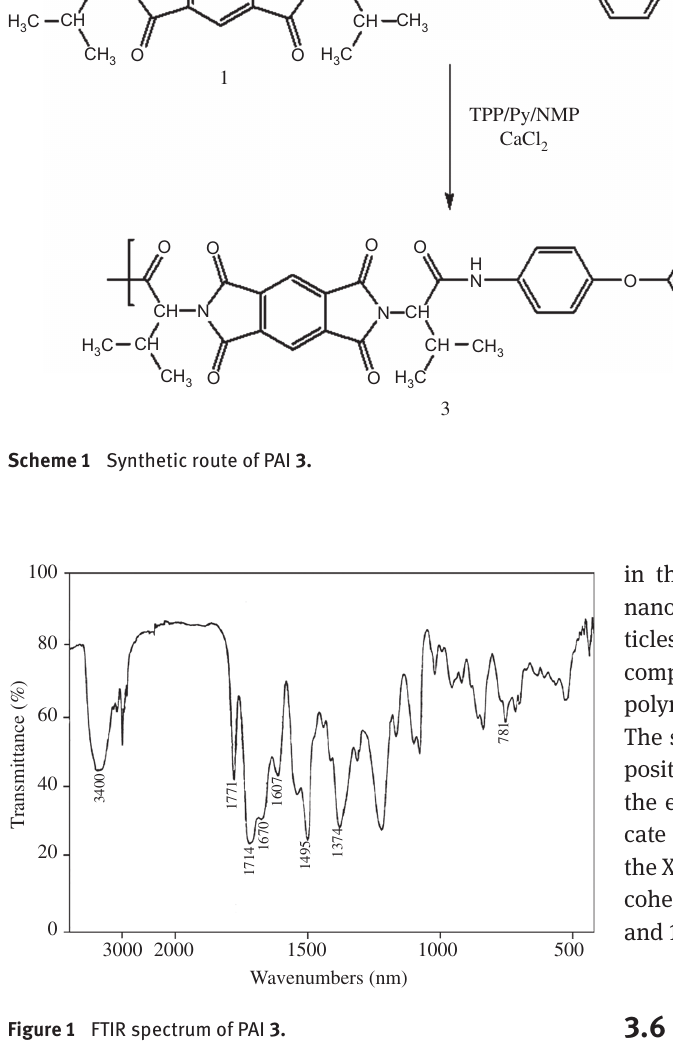
Figure 1 FTIR spectrum of PAI